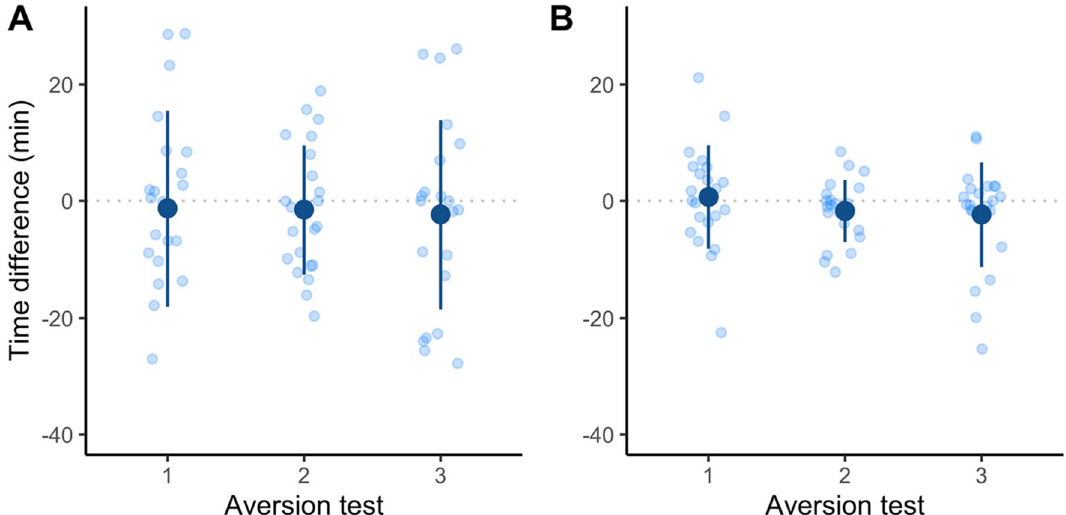
Figure 1. Conditioned place aversion results. Distribution of time differences spent in pens where calves (n = 22 for each trial) had previously been disbudded. Positive values reflect calves spending more time in a pen where they experienced analgesic effects towards the end of conditioning. In both trials, calves orally received the analgesic ketoprofen 2 h before exiting the apparatus. In trial 1 ( A ), it was compared to exiting the apparatus immediately after ketoprofen treatment. In trial 2 ( B ), it was compared to receiving ketoprofen 4 h before exiting the apparatus. Aversion tests 1, 2 and 3 took place 48 h, 72 h and 96 h after the last conditioning treatment. Dark blue circles and lines represent mean and standard error of the mean. Light blue circles represent individual